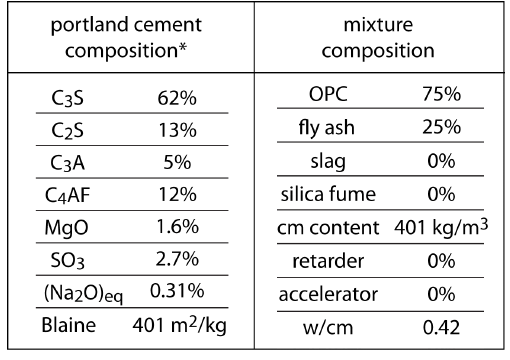
Figure 12. Lattice representation of symmetric portion of Markham Ravine bridge deck. The locations of thermocouples TC1, TC2, TC3 (midspan) and TC4, TC5, TC6 (over girder stem) are indicated. Dimensions are in meters.